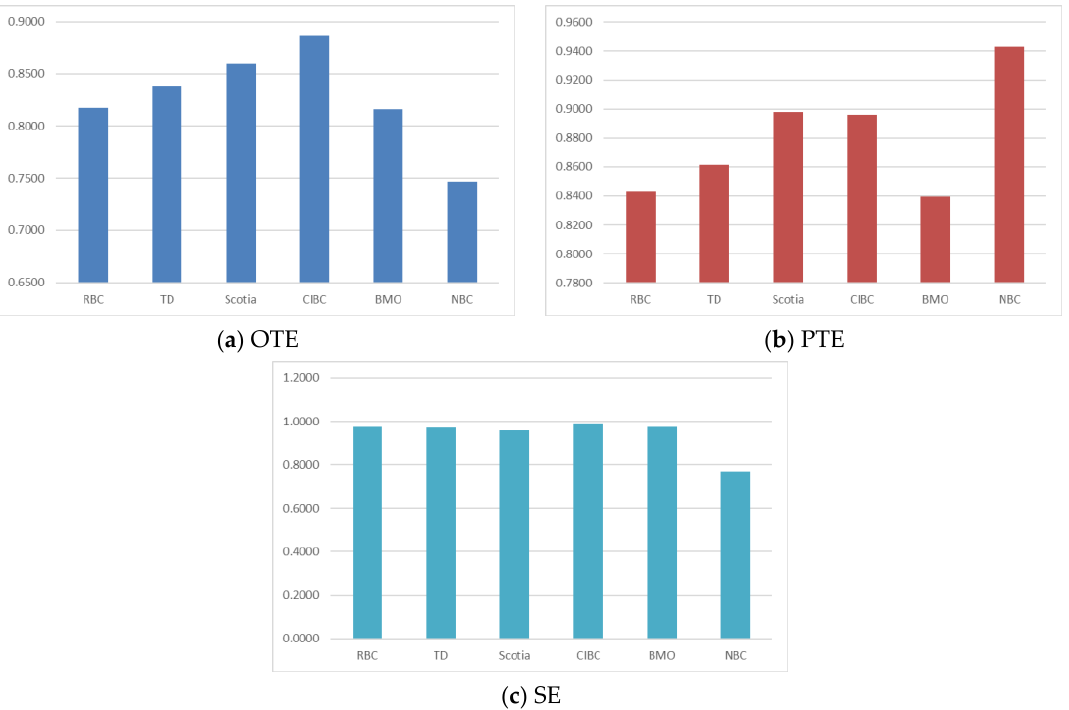
Figure 5. Banks’ bootstrap OTE, bootstrap PTE, and the SE for the first stage.